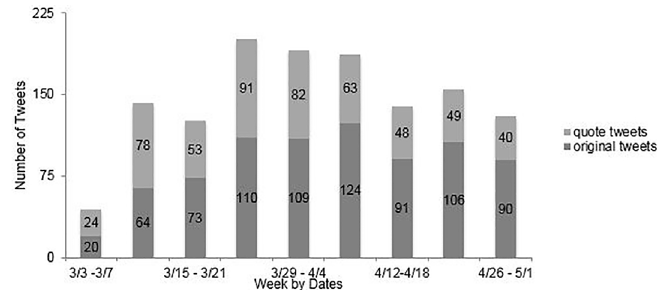
Figure 1. Original COVID-19-related tweets and quote tweets per week.